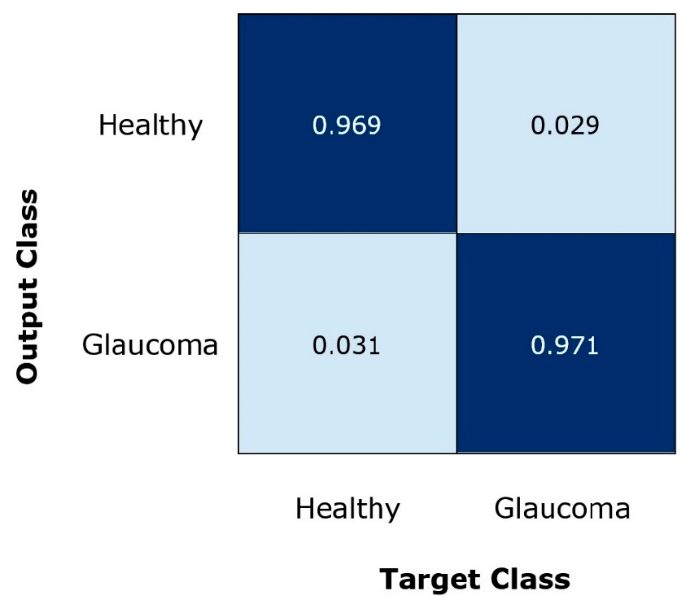
Figure 7. Confusion Matrix of the introduced framework.